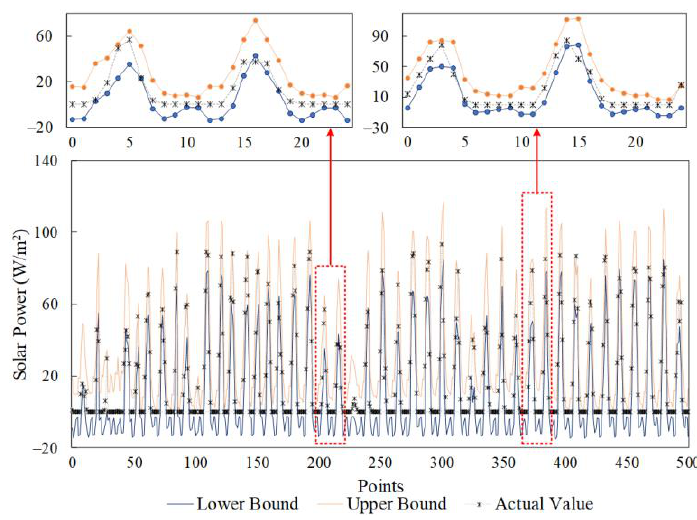
Energies 2019 , 12 , x FOR PEER REVIEW Figure 13. The prediction result obtained by SA and WI w / o ELM-AE. Figure 13. The prediction result obtained by SA and WI w/o ELM-AE.